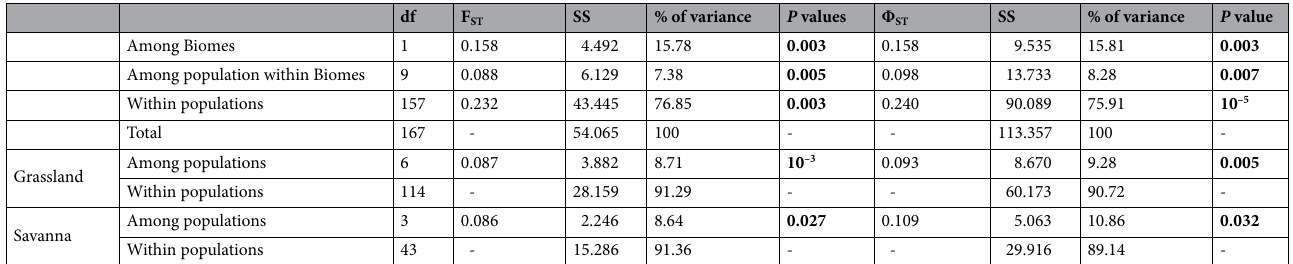
Table 2. Analyses of molecular variance (AMOVAs) based on F ST and φ ST values for 11 populations of D. vittatus distributed in two Biomes. df: degree of freedom; SS: sum of squares; p -value: level of statistical significance. Statistically significant and higly significant results are shown in bold